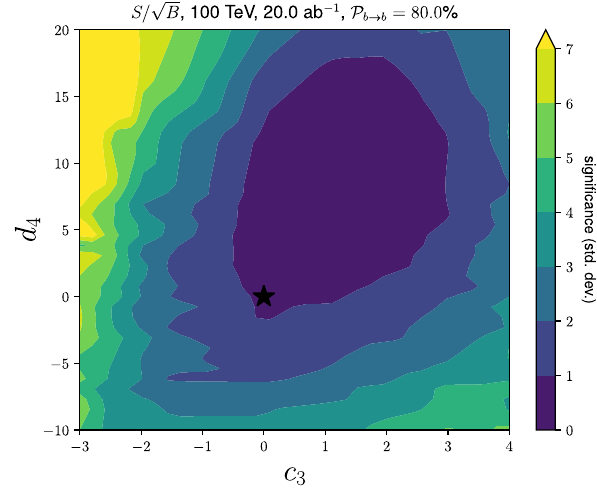
Fig. 11 The significance for our analysis of triple Higgs boson pro- duction in the ( b ¯ b )( b ¯ b )( b ¯ b ) final state with modified self-couplings ( λ 4 = λ SM ( 1 + d 4 ) and λ 3 = λ SM ( 1 + c 3 ) ) at the FCC-hh at 100 TeV. We have assumed an integrated luminosity of 20 ab − 1 and b -tagging efficiency of 80%. The black star indicates the SM point